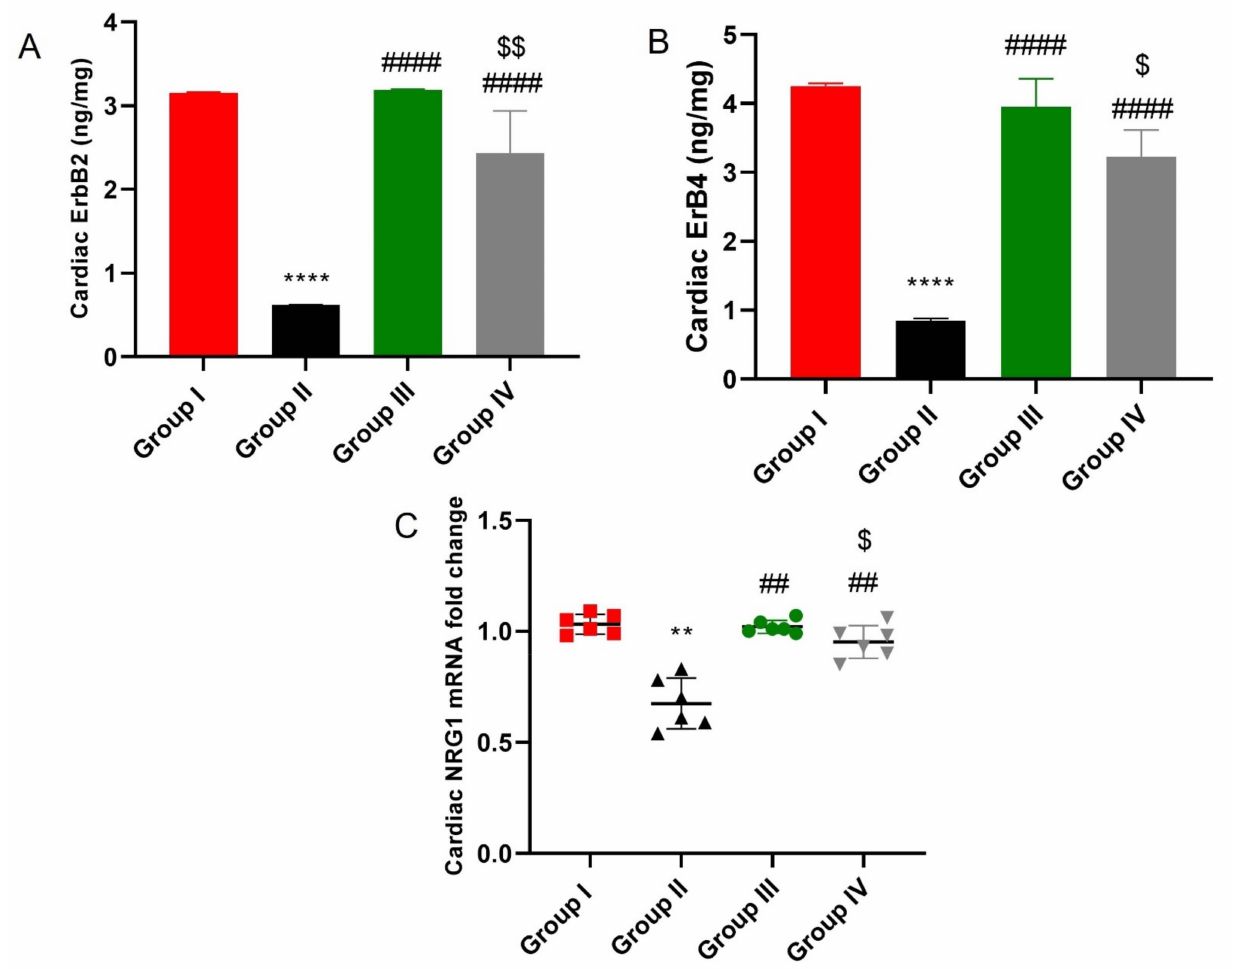
Figure 7. Effect of ADMSCs-derived exosomes on NRG-1/HER2 signaling in cardiac tissue of DOX/Trz-treated rats: ( A , B ) HER2 and ERB4 concentration determined by ELISA. Results are expressed as mean ± SEM; and ( C ) mRNA levels of cardiac NRG-1. Data are expressed as median (maximum, minimum). **, significant compared to Group I at p < 0.01; ****, significant compared to Group I at p < 0.0001; ##, significant compared to Group II at p < 0.01; ####, significant compared to Group II at p < 0.0001; $, significant compared to Group III at p < 0.05; n =